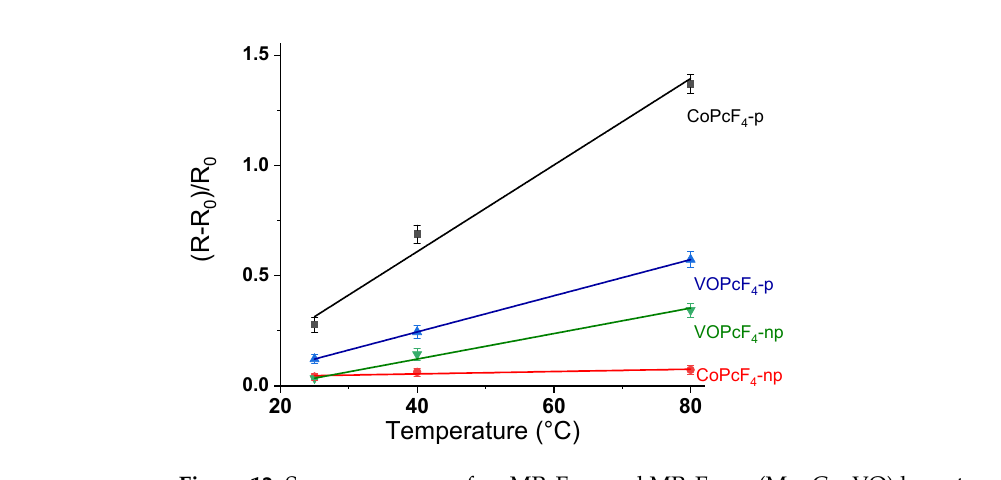
Figure 12. Sensor response of an MPcF 4 -p and MPcF 4 -np (M = Co, VO) layer to ammonia (3 ppm) measured at 25, 40 and 80 °C.